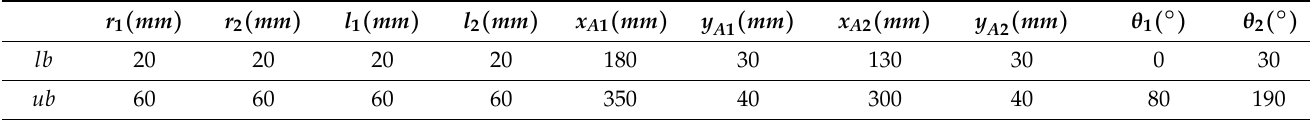
Table 1. Lower ( lb ) and upper ( ub ) bounds of the design variables in the optimization